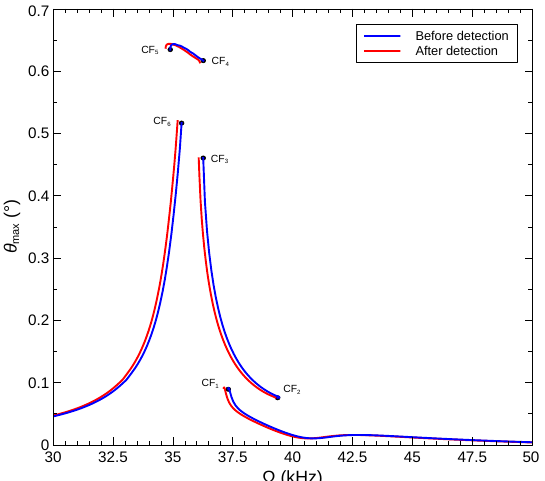
Figure 17. The maximum rotation angle of the rigid arm over the orbit for sensors made of an arch microbeam with an initial rise of w o = 6µm under the voltage waveform V DC = V AC =